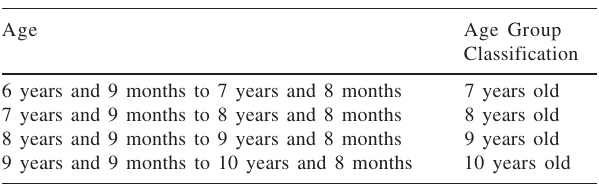
Table 1 - Definition of children age groups as employed in this